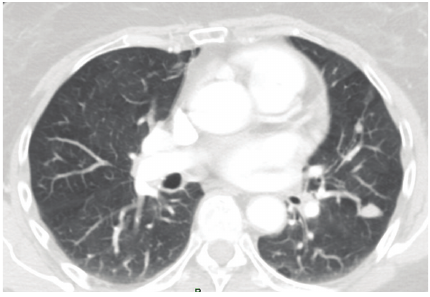
Figure 2: CT scan with lung